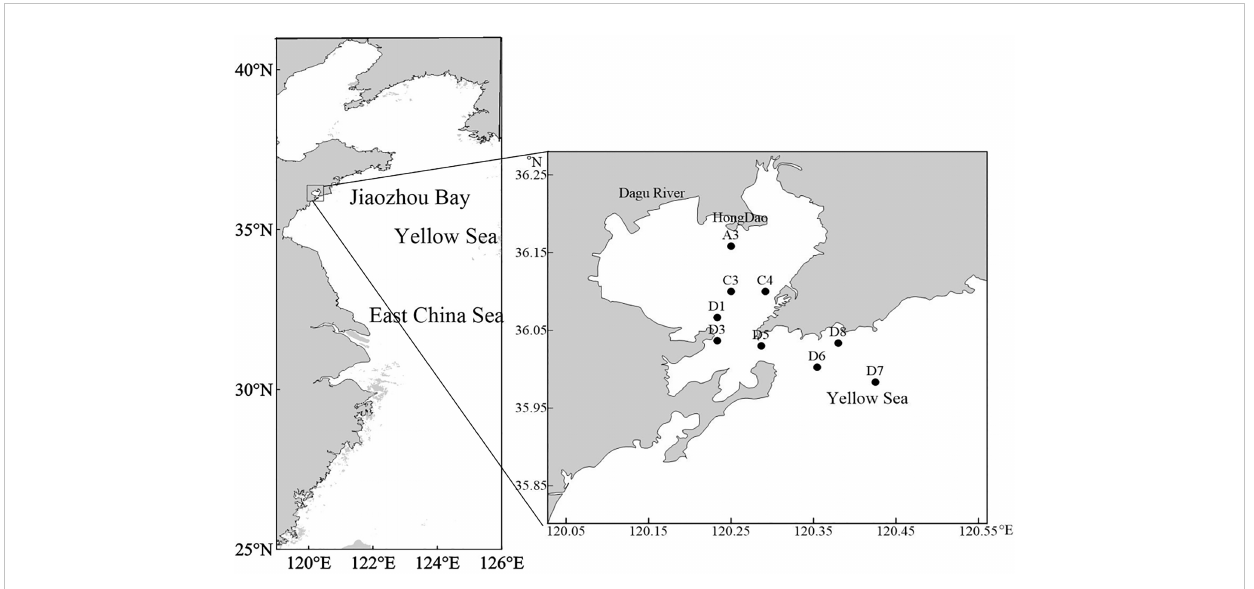
FIGURE 1 Map of Jiaozhou Bay and the location of the sampling